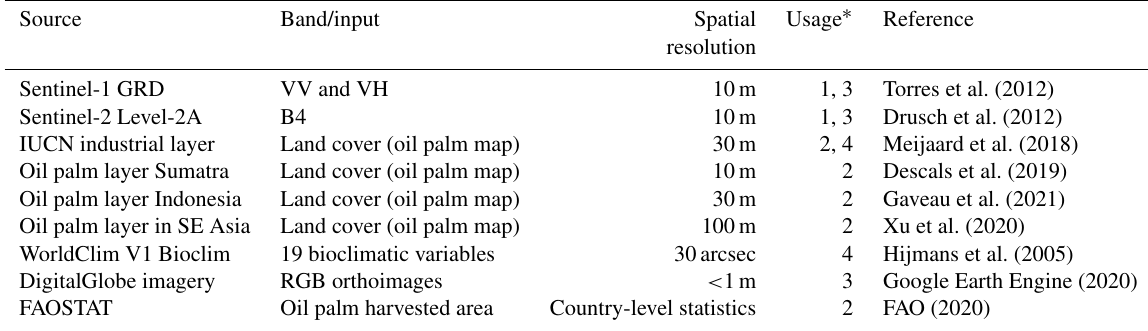
Table 1. Data sources used in the